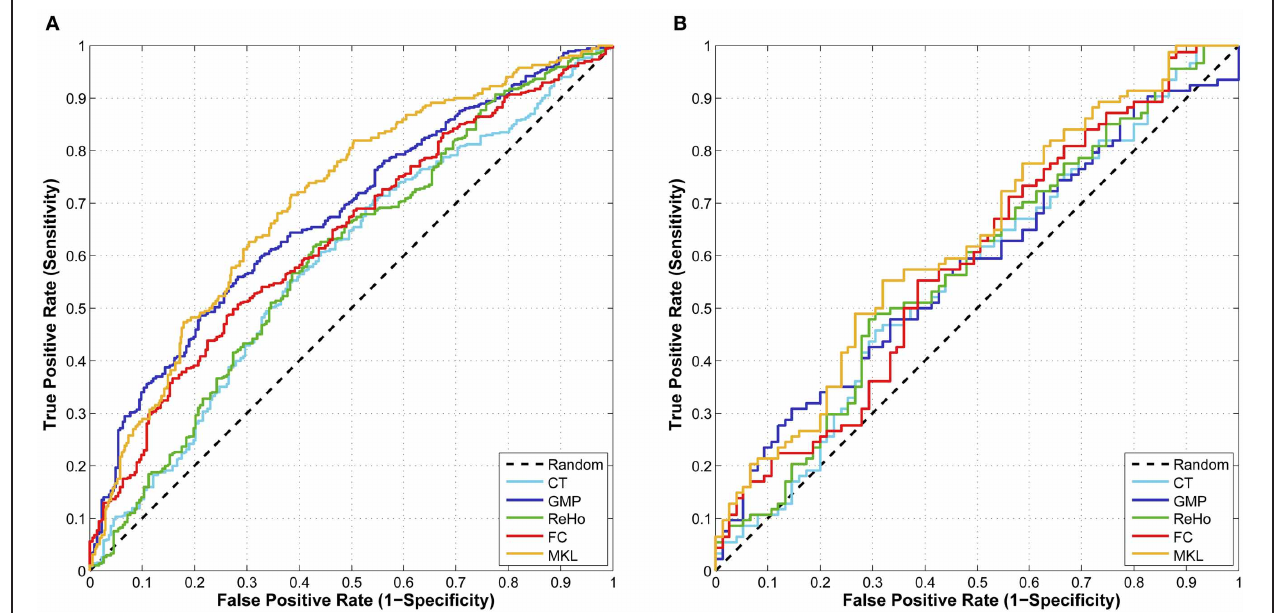
FIGURE 2 | (A) The ROC curve of CV classification on training set of 624 subjects; (B) The ROC curve of classification on test set of 169 subjects.